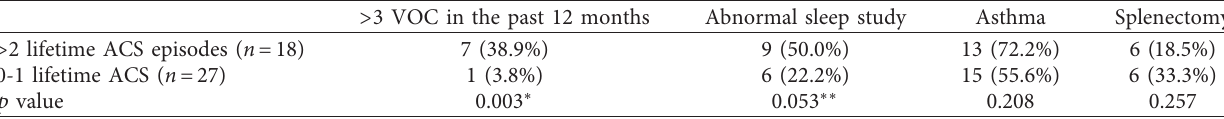
Table 2: Risk factors for two or more lifetime ACS admissions. > 3 VOC in the past 12 months Abnormal sleep study